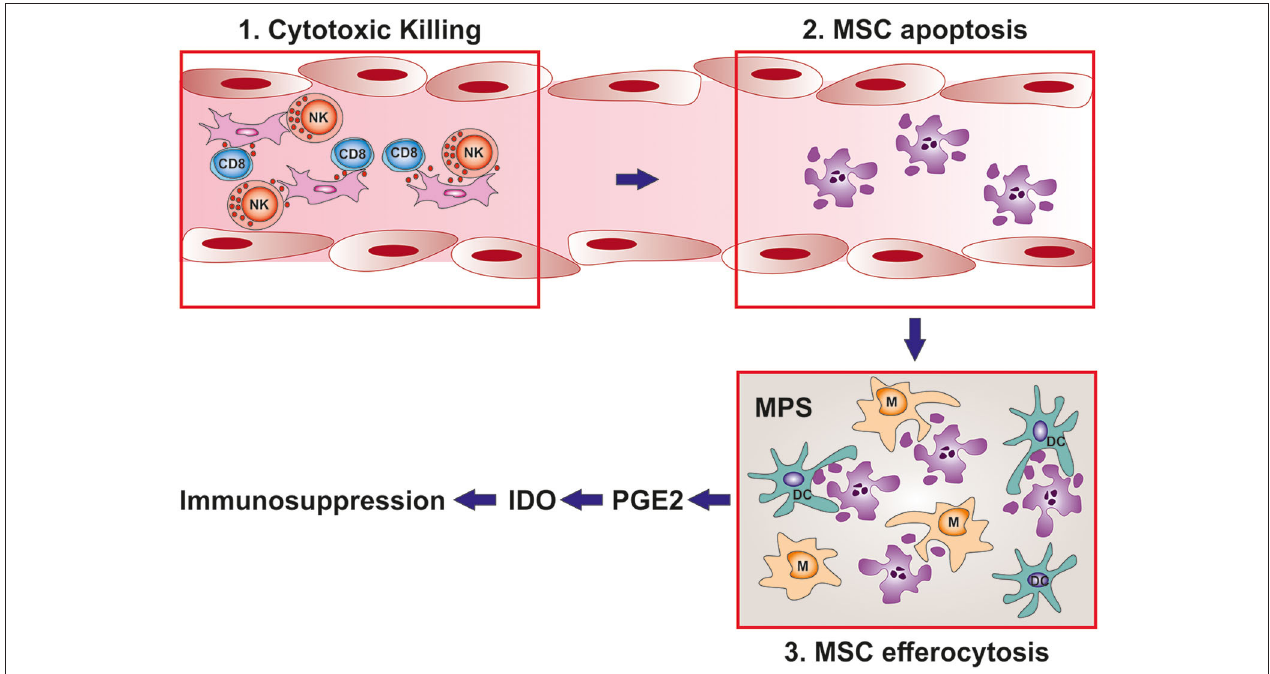
FIGURE 2 | MSC immunomodulation depends on the interaction with the host. Schematic representation of MSC mediated immunosuppression after infusion. 1: After infusion, MSCs interact with the cytotoxic granules produced by CD8T cells and NK cells of MSC recipient. 2: MSCs are induced to undergo apoptosis. 3: apoptotic MSCs are cleared from the circulation by the mononuclear phagocyte system. After efferocytosis, phagocytic cells of MSC recipient are induced to produce PGE2 and IDO which are the final mediator of MSC immunosuppression. Importantly, while the cytotoxic activity against MSC can be used as a biomarker to predict the response before MSC infusion, PGE2 levels in patient serum could be devised to monitor response after